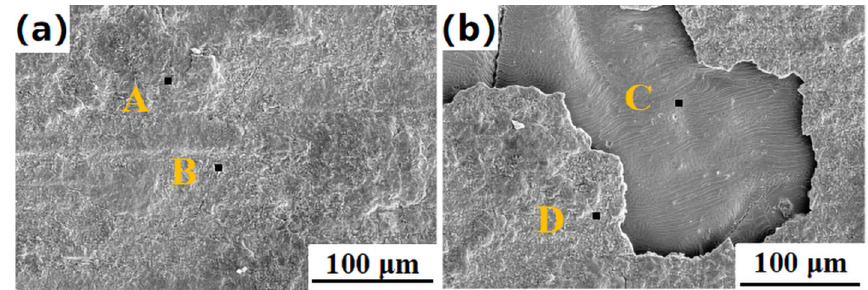
Figure 15. Microstructure of the shear fracture of a Si 3 N 4 /Ti/Cu///Kovar/Cu/Ti/Ht250 joint: ( a ) 2 MPa, 1000 °C, 15 min; ( b ) 2 MPa, 1000 °C, 1 h. Table 7. Component content of each point in Figure 15a (at %).